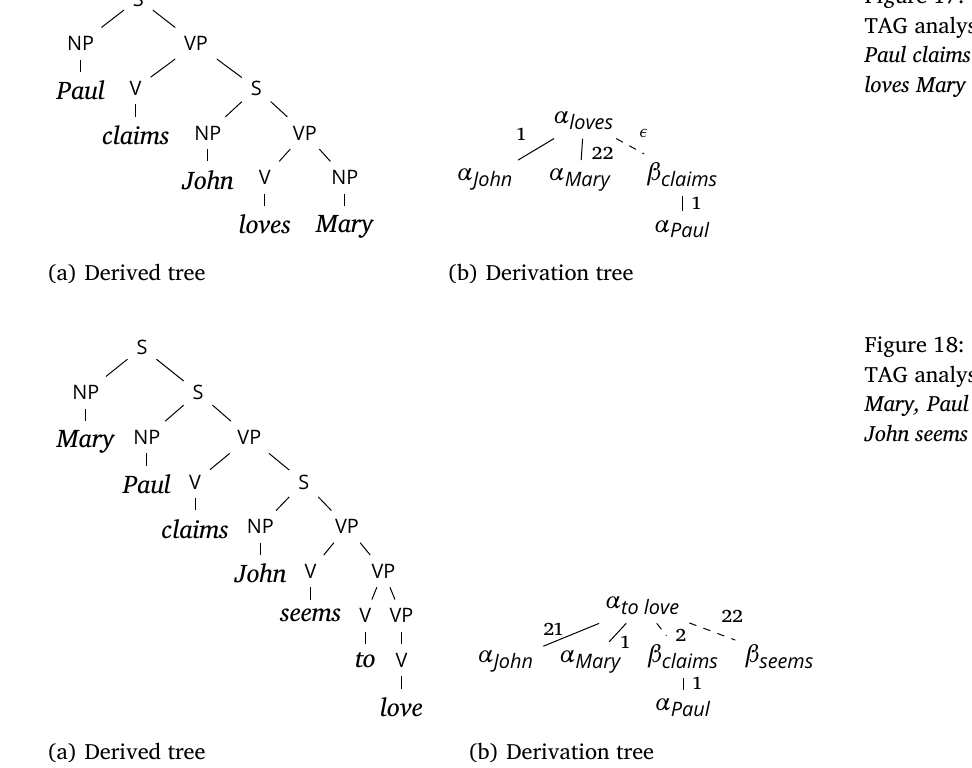
Paul claims John